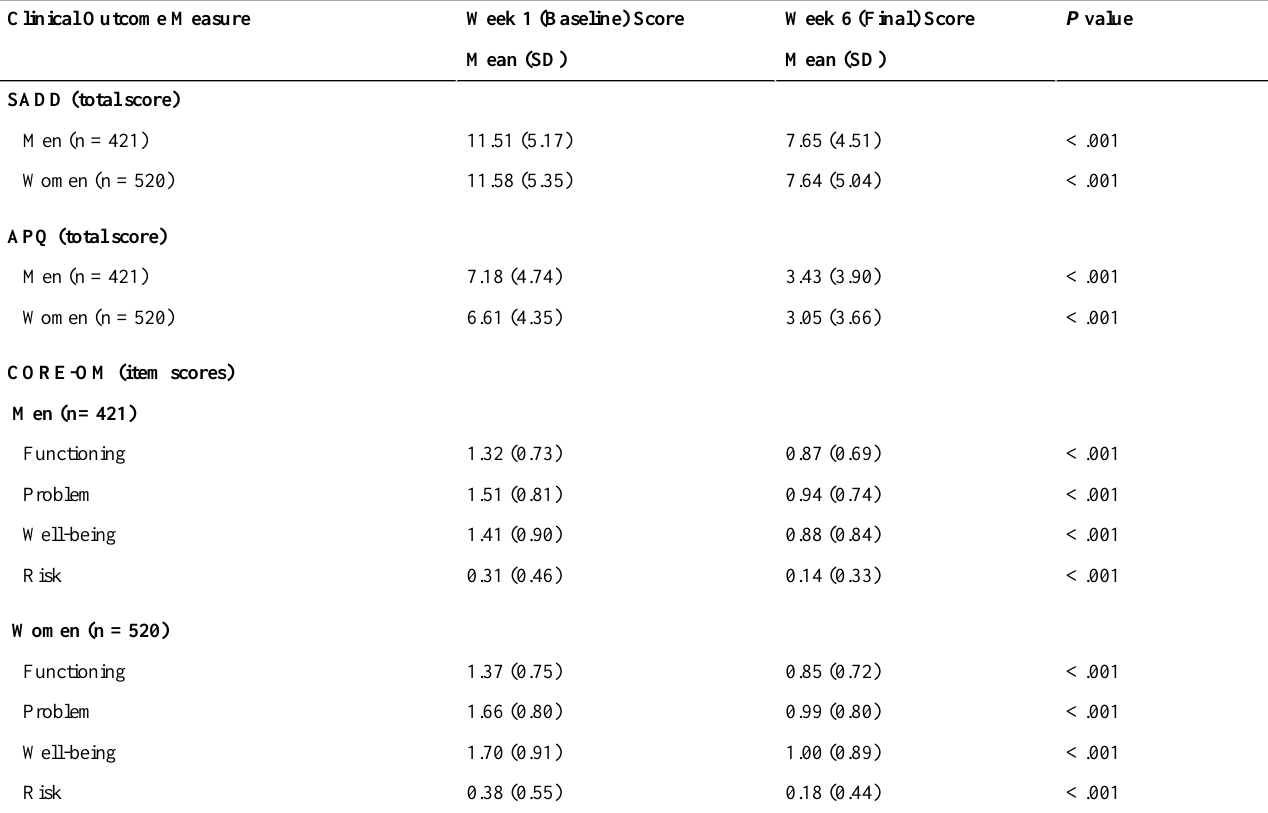
Table 4. Change in clinical outcomes between week 1 and week 6 in users who completed the 6-week